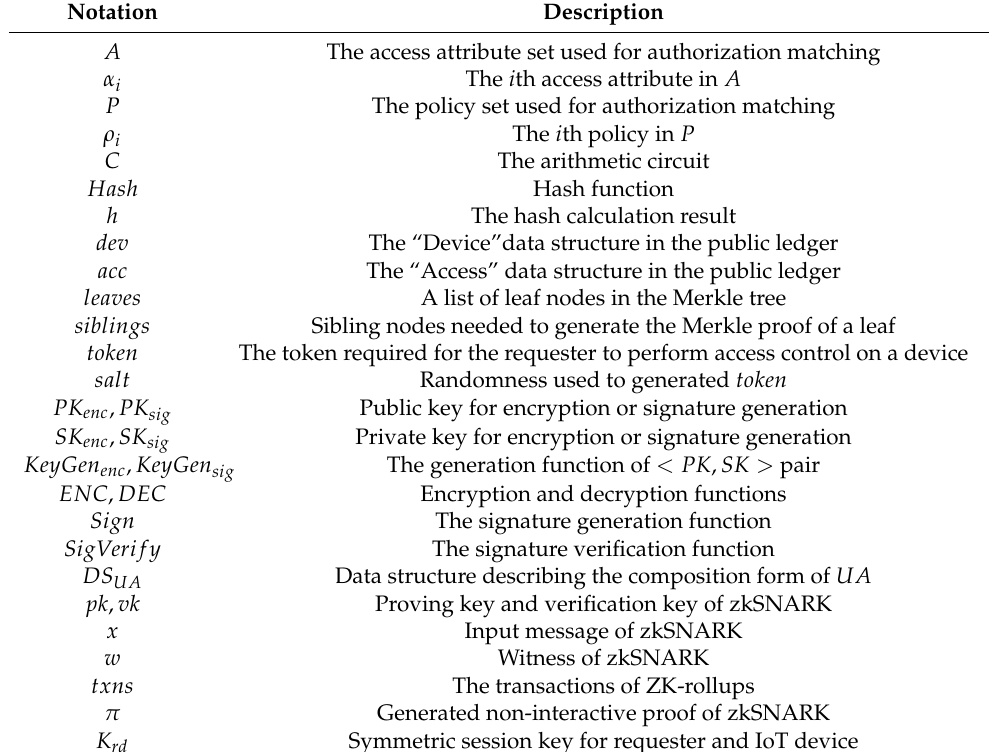
Table 1. Notations List.